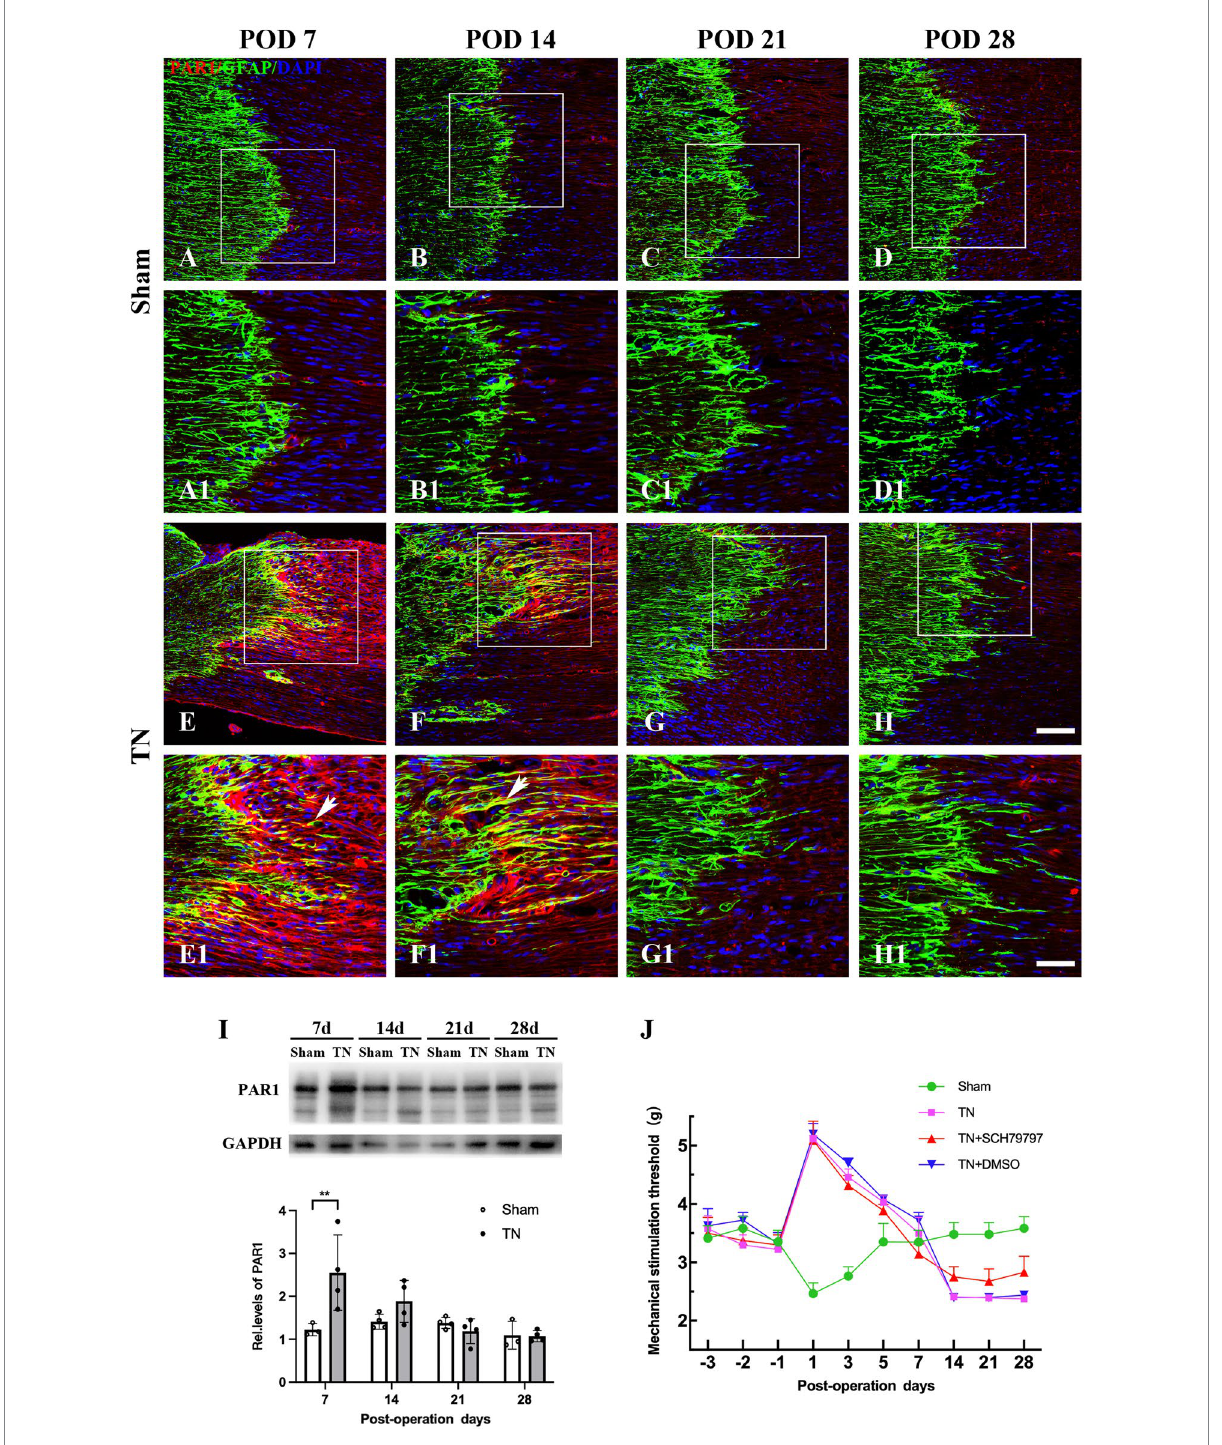
FIGURE 7 Changes in the expression and distribution of PAR1 in the TREZ of rats. (A–D) PAR1 (red) was expressed at low levels in the TREZ in the sham group. (E–H) PAR1 (red) expression in rats in the TN group was increased compared with that in rats in the sham group. Some PAR1 was expressed in GFAP-positive astrocytes (white arrows). (A–H) Bar = 100 μ m, A1-H1: bar = 50 μ m. (I) On POD 7, the expression of PAR1 protein in the TREZ of rats in the TN group was significantly higher than that in rats in the sham group. On PODs 14, 21, and 28, PAR1 expression in the TN group gradually decreased until it was similar to that in the sham group. Data are expressed as the mean ± SD ( n = 3 or 4/group) and were analyzed using two-way ANOVA followed by Sidak’s multiple comparisons test. ** p < 0.01 . (J) The orofacial mechanical stimulation thresholds of rats in different groups. In contrast to the sham group, rats in the other three groups all displayed a markedly higher orofacial mechanical pain threshold on POD 1, which